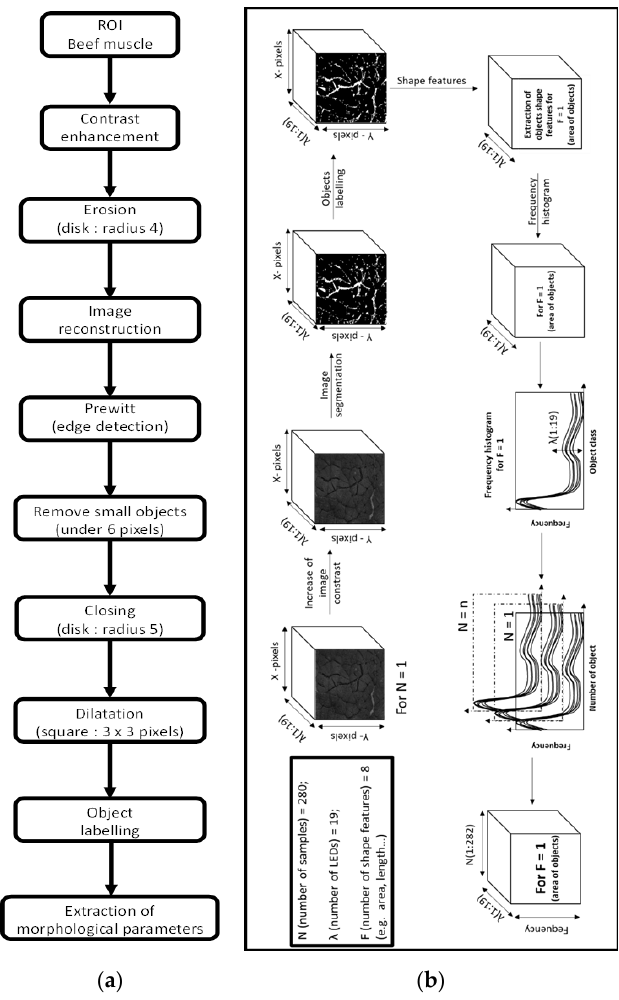
Figure 1. ( a ) Detailed schematic sequence for extraction of the shape parameters of meat marbling for one multispectral image and ( b ) sequence describing the organization of the histograms of the frequencies of the objects extracted from the dataset. ROI: region of interest; LED: Light-emitting